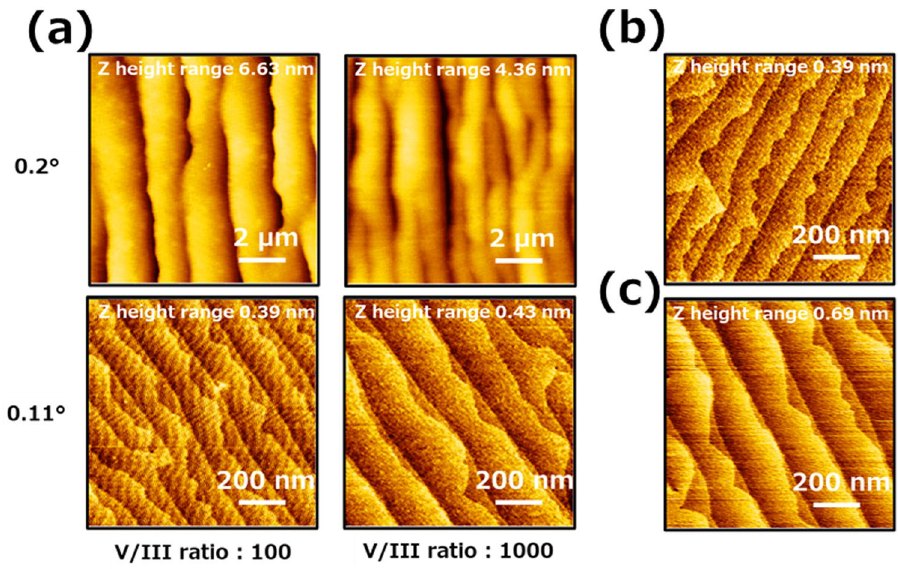
Figure 3. The AFM images with the V/III ratios of 100 and 1000 on a sapphire off-angle of 0.2° and 0.11°. ( a ) The second AlN layer growth for 30 min. ( b ) The second AlN layer growth for 0 min on a sapphire off-angle of 0.11°. ( c ) The second AlN layer growth for 0.2 min at V/III ratio 1000 on a sapphire off-angle of